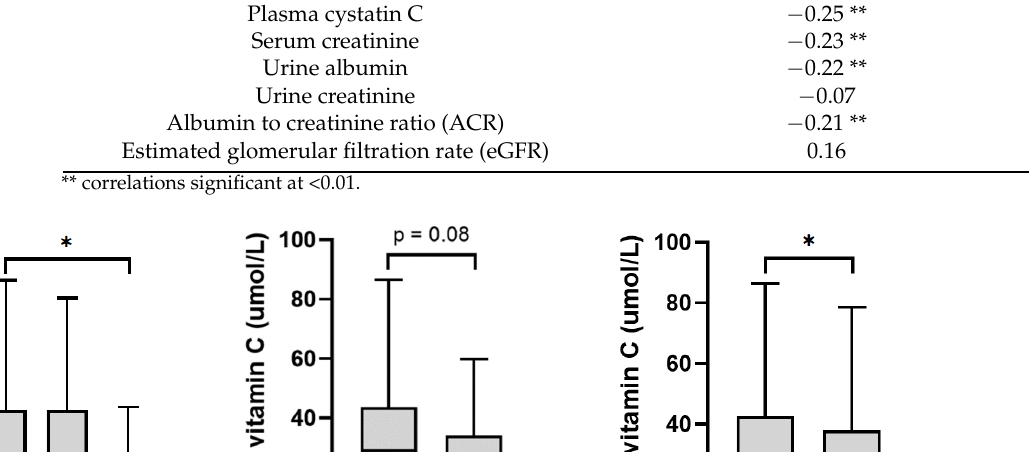
Table 3. Correlations of plasma vitamin C status with renal function parameters ( n = 136). Parameter Spearman Correlation ( r )